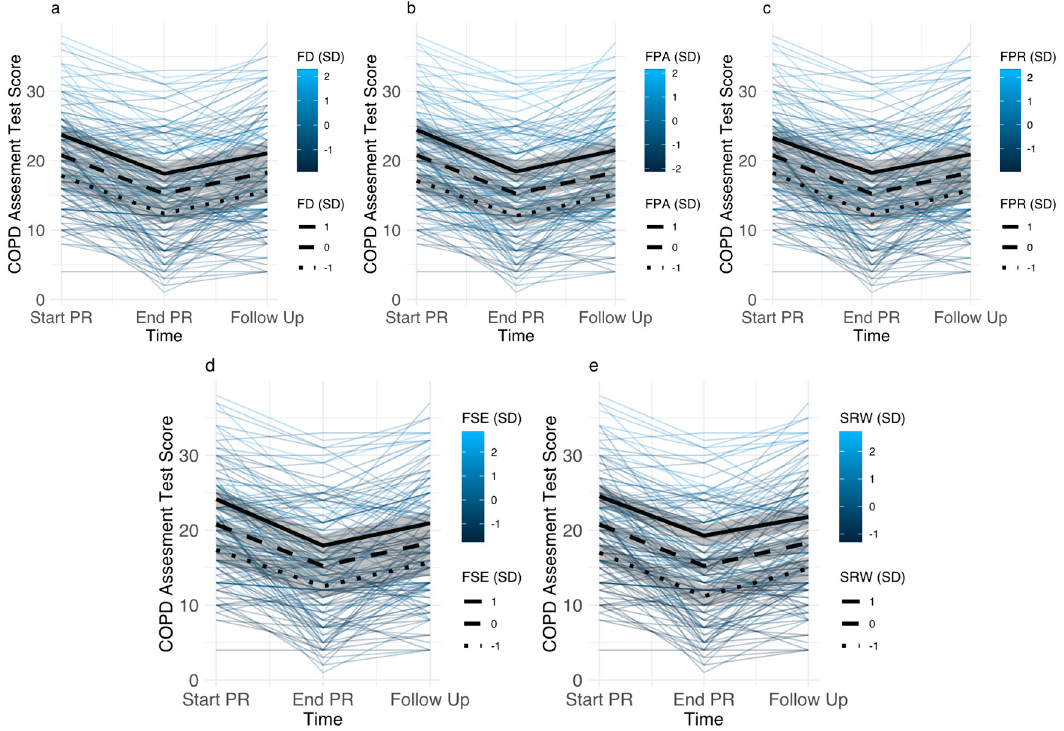
Figure 2. Individual trajectories of COPD assessment test (CAT) scores for participants with different levels of disease-specific fears (color indicates level of disease-specific fear). Estimated trajectories for participants with disease-specific fear scores 1SD above mean, mean, and 1SD below mean (95% CI) are superimposed. ( Panel a ): Fear of Dyspnea (FD), ( Panel b ): Fear of Physical Activity (FPA), ( Panel c ): Fear of Progression (FPR), ( Panel d ): Fear of Social Exclusion (FSE), ( Panel e ): Sleep-Related Worries